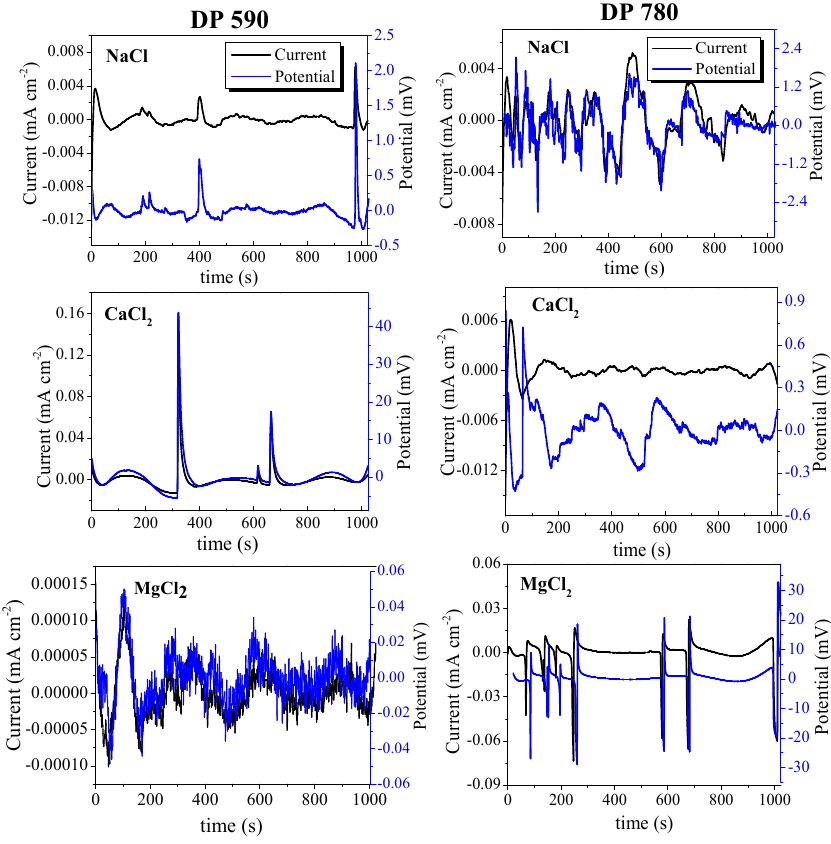
Figure 3. Removing DC trend from the electrochemical current and potential noise for DP590 and DP780 steels in different solutions.